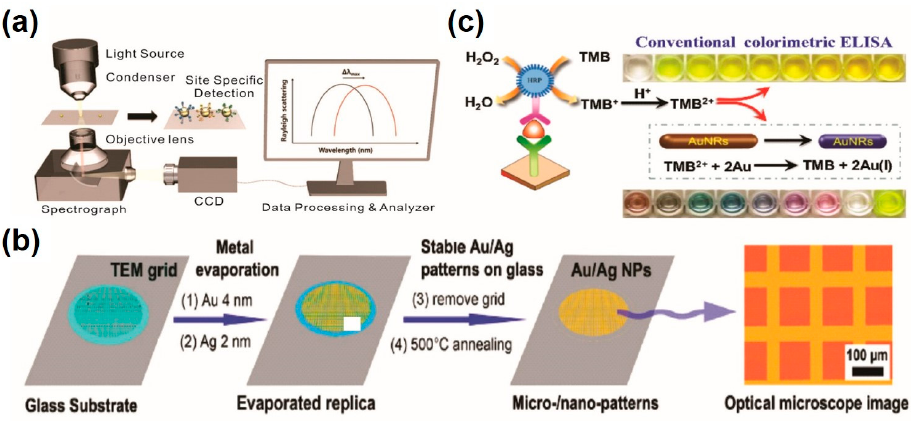
Figure 2. Localized surface plasmon resonance (LSPR)-based immunosensors for protein biomarker detection. ( a ) Selective recognition of multiplex cancer biomarkers by LSPR immunosensor; ( b ) signal enhancement of LSPR-based immunosensor by employing bimetallic nanostructures; ( c ) LSPR band shift based on the GNR etching resulted by TMB reaction. ( a ) Figure reproduced with permission from [37], © 2015 Elsevier; ( b ) Figure reproduced with permission from [38], © 2014 American Chemical Society; ( c ) Figure reproduced with permission from [39], © 2017 Elsevier.